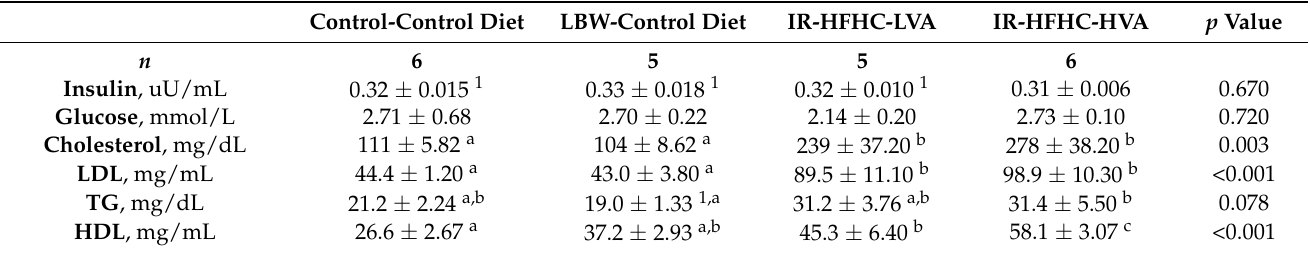
Table 4. Fasting plasma lipid, glucose, and insulin concentrations of control and LBW pigs fed control, HFHC-LVA, and HFHC-HVA diets until 10 weeks of